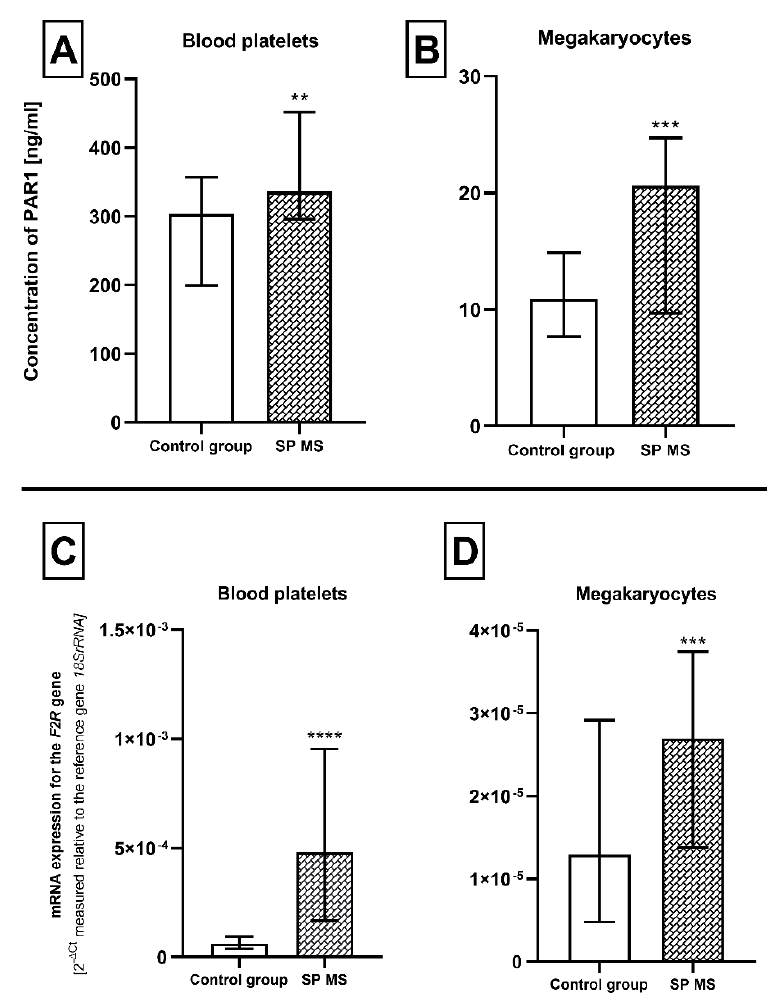
Figure 3. The level of PAR1 (ng / mL) ± SD and the relative expression of the F2R gene (according to the reference gene— 18SrRNA ) measured at the mRNA level in platelets ( A and C , respectively) and megakaryocytes ( B and D , respectively) from SP MS patients ( n = 45) and the control group ( n = 45). Statistical analysis was performed using the Mann–Whitney U test. The results are expressed as a median and interquartile range (IQR), ** p < 0.01, *** p < 0.001, **** p < 0.0001.